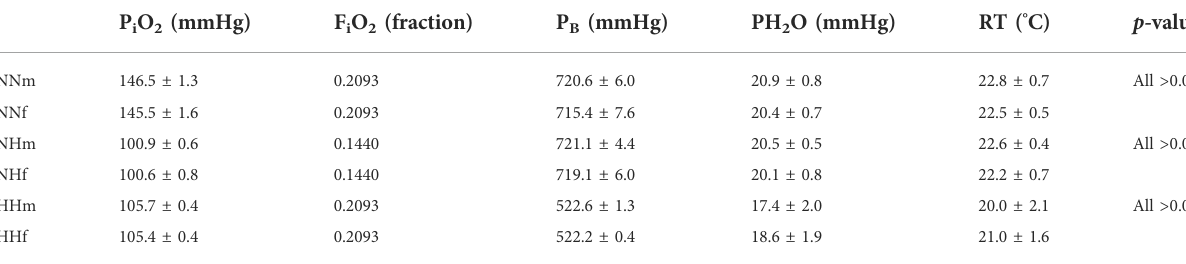
TABLE 1 Environmental conditions. N = 20, one-way ANOVA.